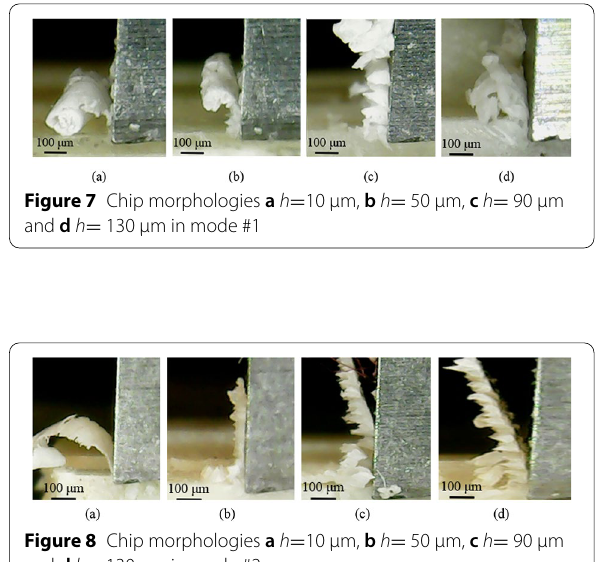
Figure 6 Experimental setup for orthogonal cutting: a Directions of bone osteons, b Slicing over bones, and c Data acquisition system